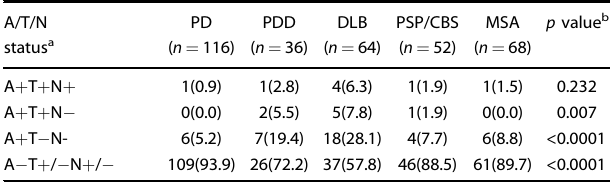
Table 4. Distribution of AD co-pathology according to the A/T/N CSF pro fi le in the main diagnostic